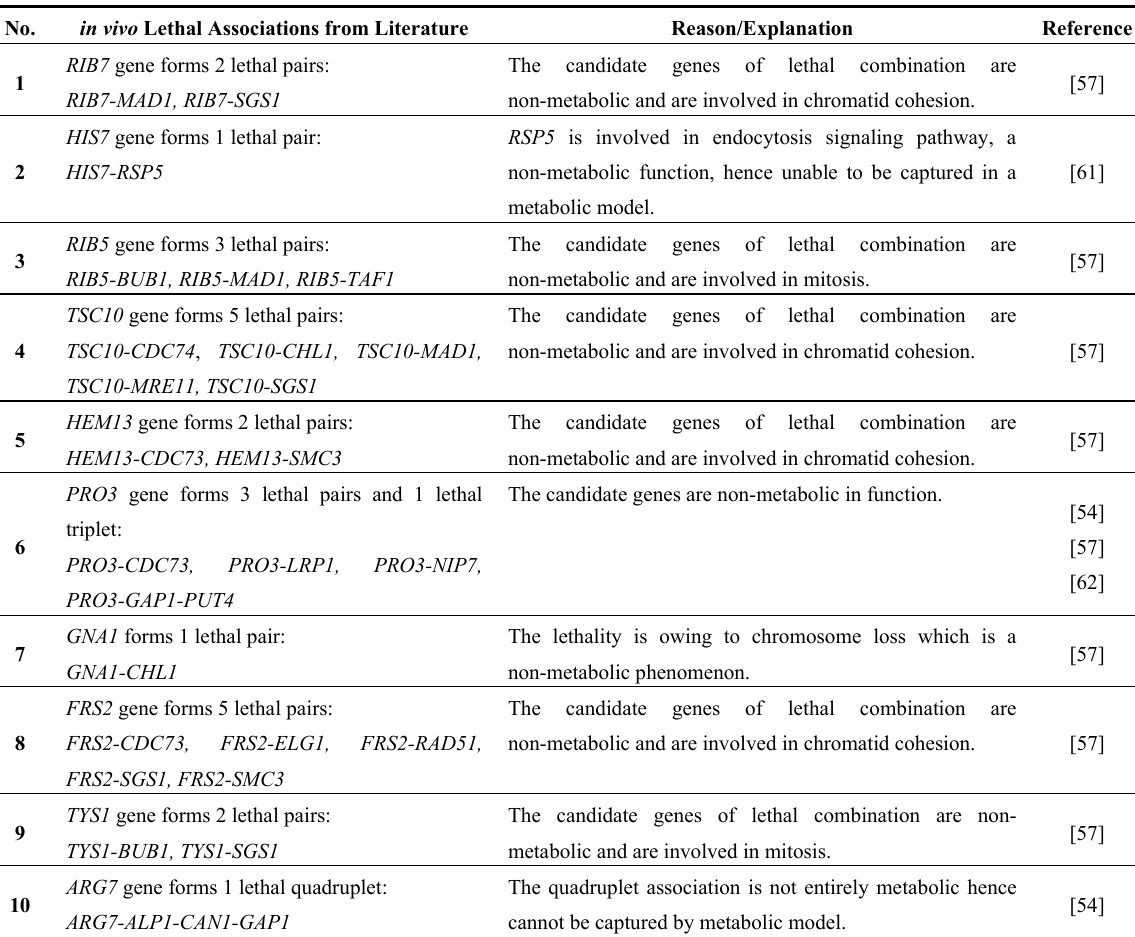
Table 4. Information about the 12 ESG cases, which form in vivo SL2 due to non-metabolic